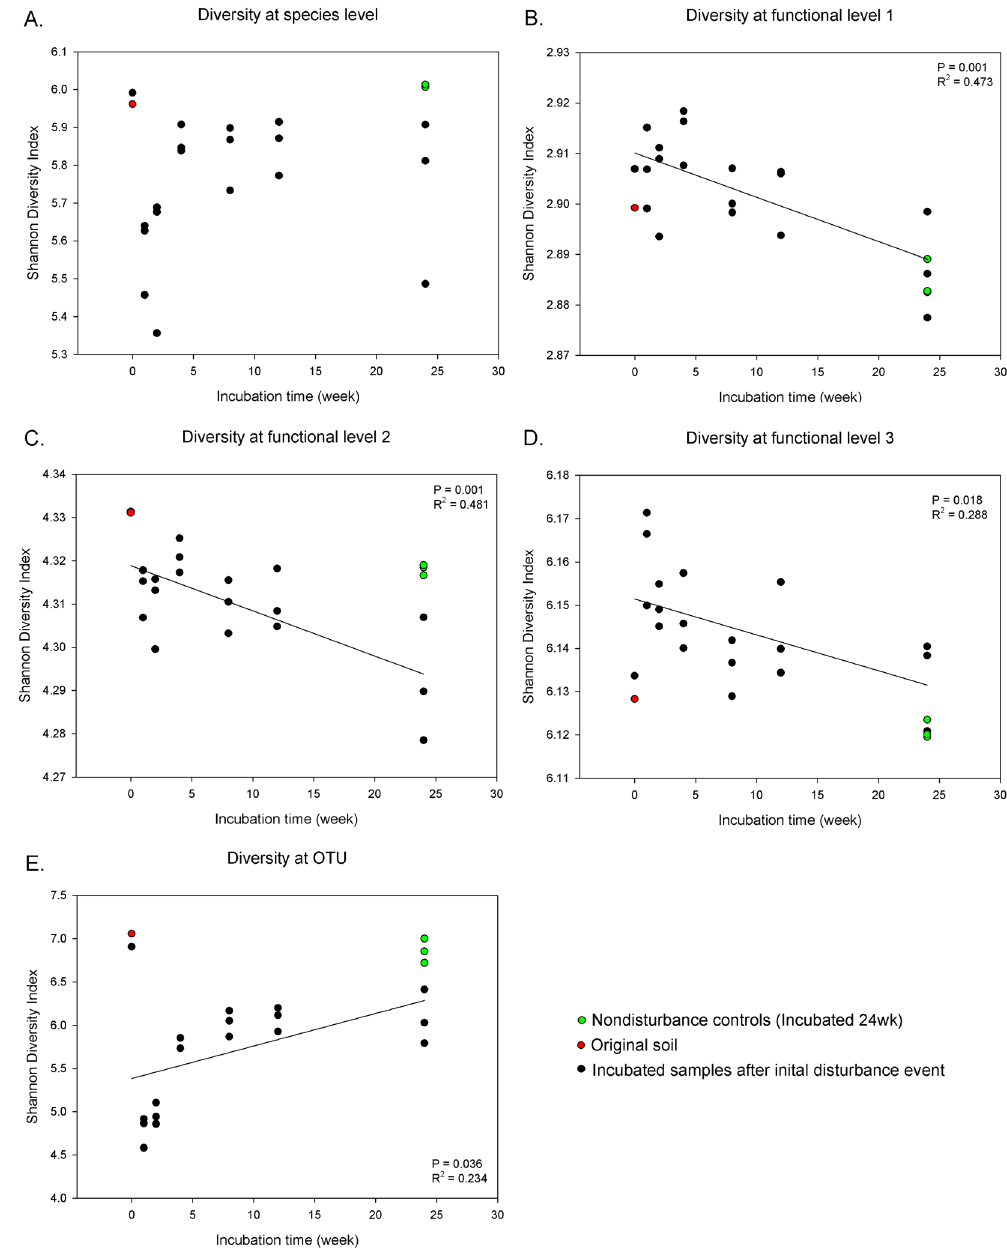
Figure 3. Taxonomic and Functional diversity (SEED database) at soil microbial communities by incubation time based on Shannon diversity index. Solid line represents linear regression fits to data. Diversity at ( A ) species level from all kingdoms (M5NR database), ( B ) functional level 1, ( C ) functional level 2, ( D ) functional level 3. ( E ) bacterial OTU level. Colored points were not included in the